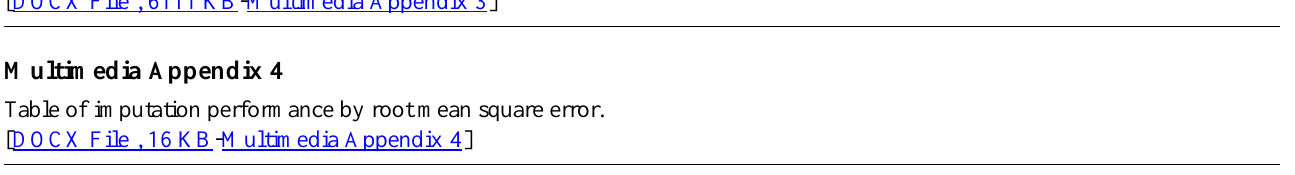
Table of imputation performance by root mean square error.